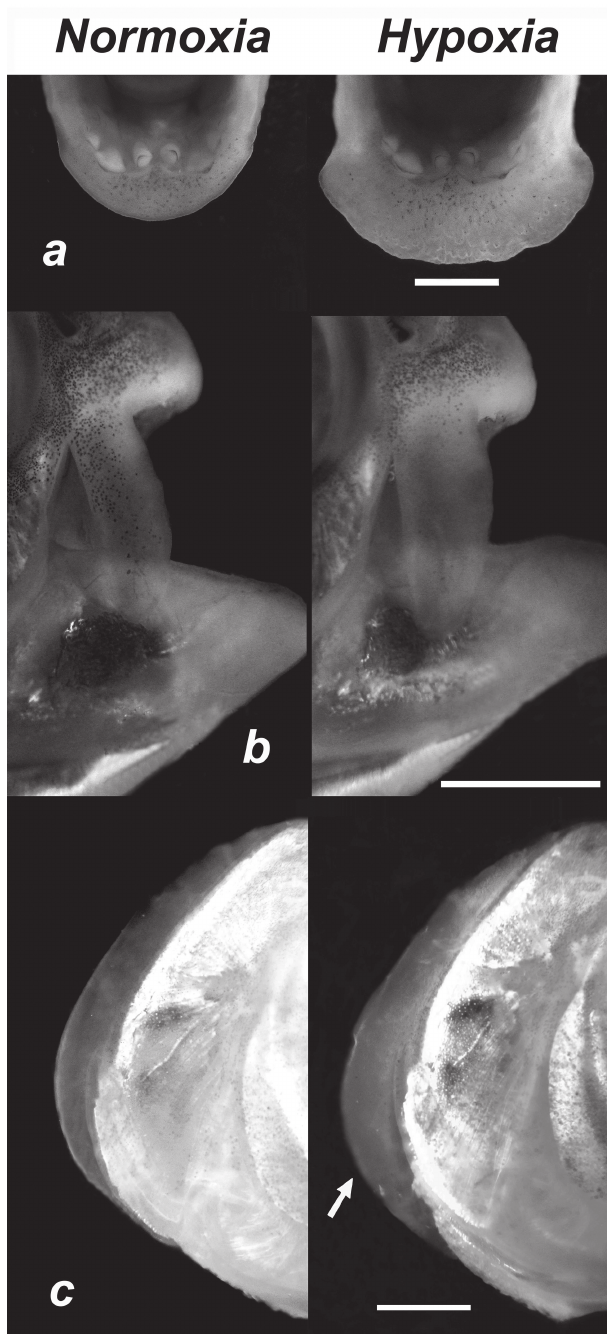
Fig. 2. Photographs showing increases in size of the three morphological traits of Piaractus mesopotamicus analyzed exposed to extreme hypoxia: (a) lower lip, (b) maxillary, and (c) opercular valve. White arrow indicates the area where the expansion of dermal tissue occurred.